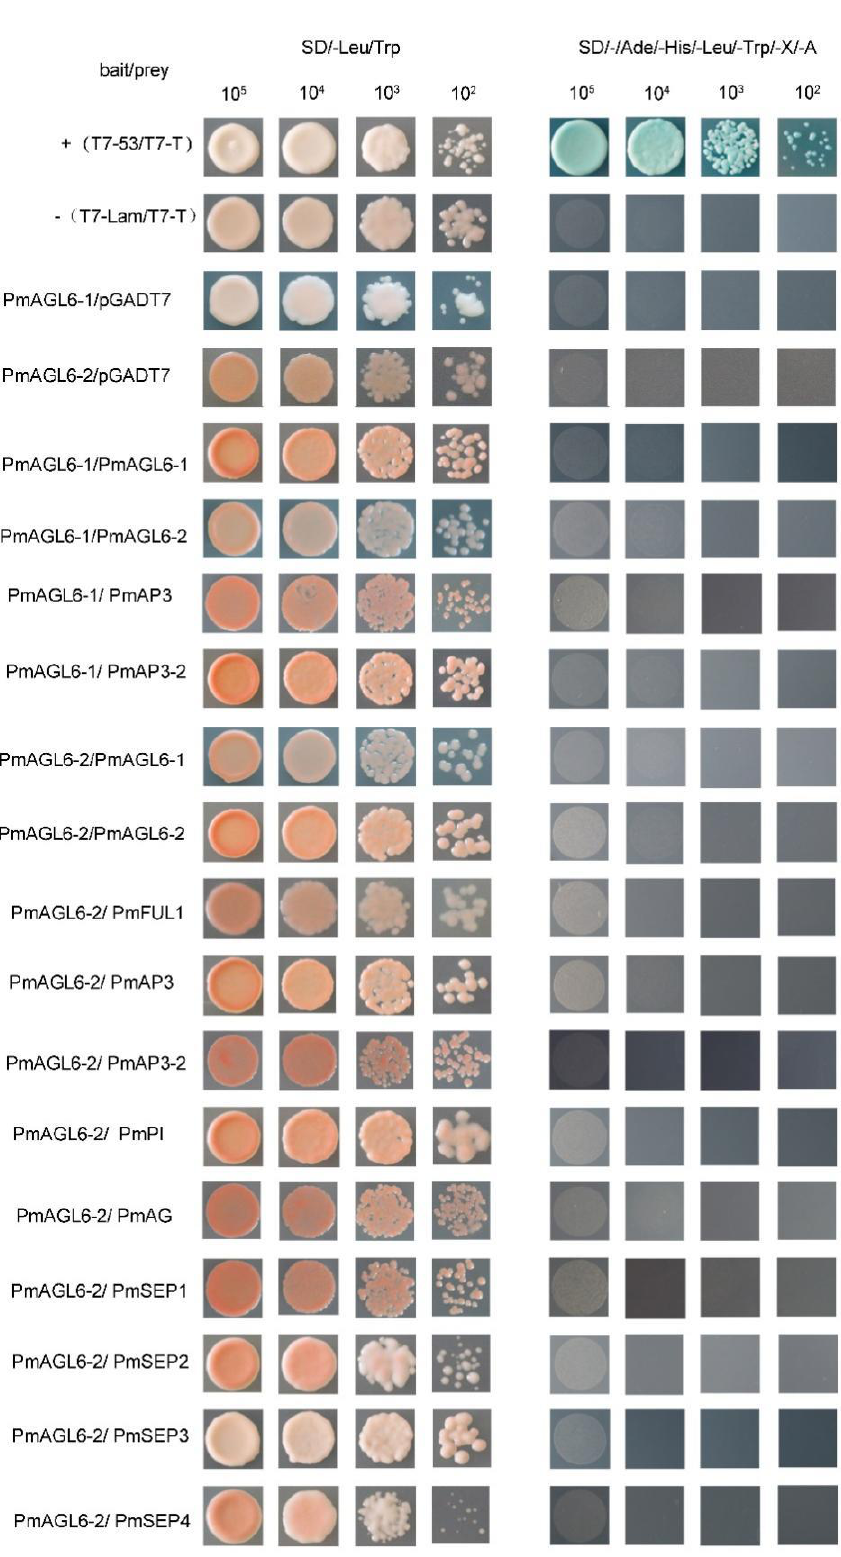
Figure 6. Positive results of the Y2H analysis of protein–protein interactions among the products of the two AGL6 genes and other floral organ identity-determining genes in P. mume . T7-53/T7-T and T7-Lam/T7-T were the positive and negative controls, respectively. + represents the intensity of the interaction and − indicates no interaction.